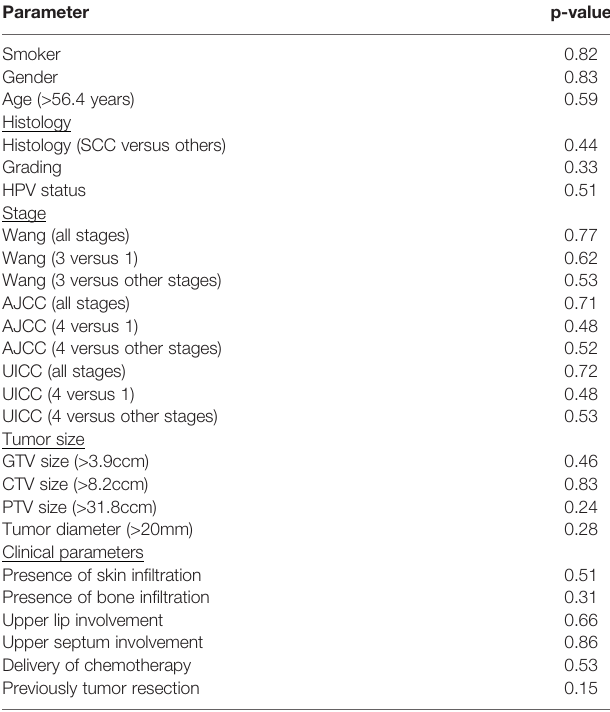
TABLE 5 | Univariate analyses on local control (Log Rank